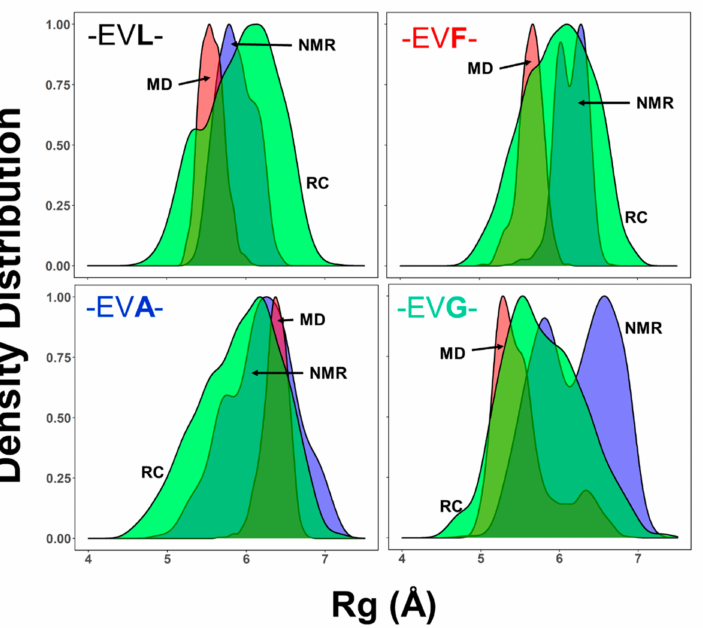
Figure 4. Comparison of the radius of gyration (Rg). Each panel shows the density plots of the distribution of Rg values between the NMR (blue shade), MD (red shade), and random coil (RC, green shade). The data from the peptides are also marked on top of each